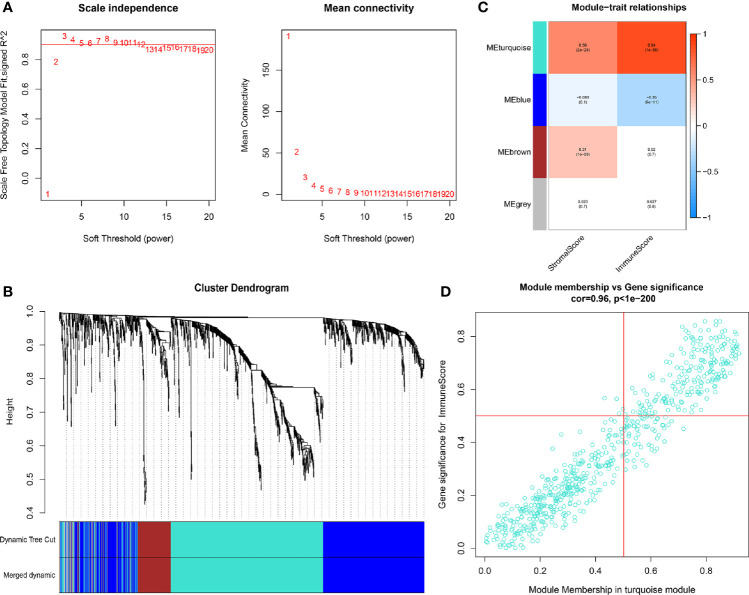

(A) In order to achieve a scale-free co-expression network, we chose power index = 3 as the appropriate soft threshold. (B) Identification of a co-expression module. The branches of the dendrogram correspond to four different gene modules. (C) Correlation between the gene modules and tumor microenvironment related scores, including immune score and stromal score. Each cell contains corresponding correlation coefficient and p-value. The correlation coefficient decreased in size from red to blue. (D) Scatter plot of module eigengenes in the turquoise module.